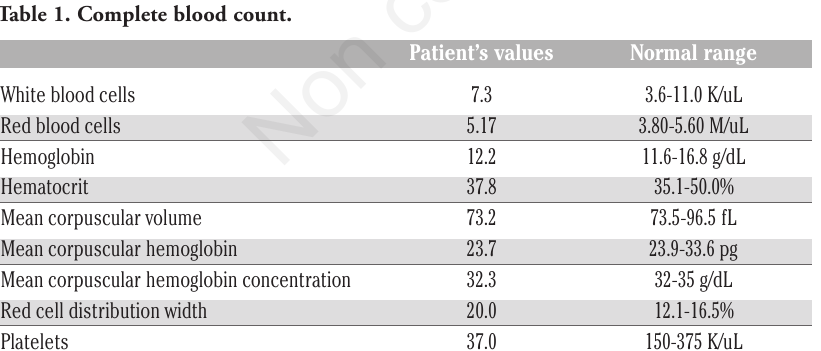
Table 1. Complete blood count.